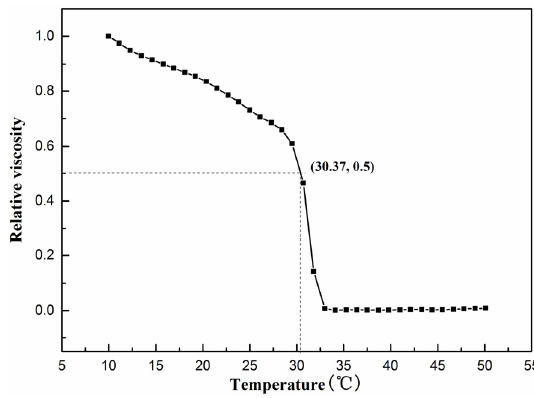
Figure 3. Thermal denaturation curve of SCSC.